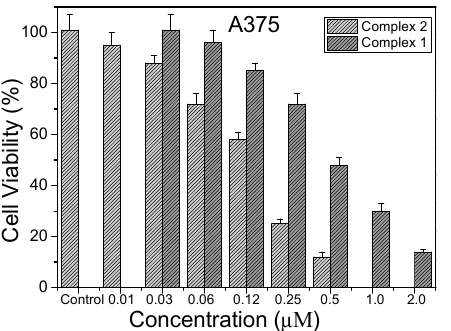
Figure 10. Photocytotoxic effects of 1 and 2 on A375 cells after 12 h incubation and 10 min irradia- tion.